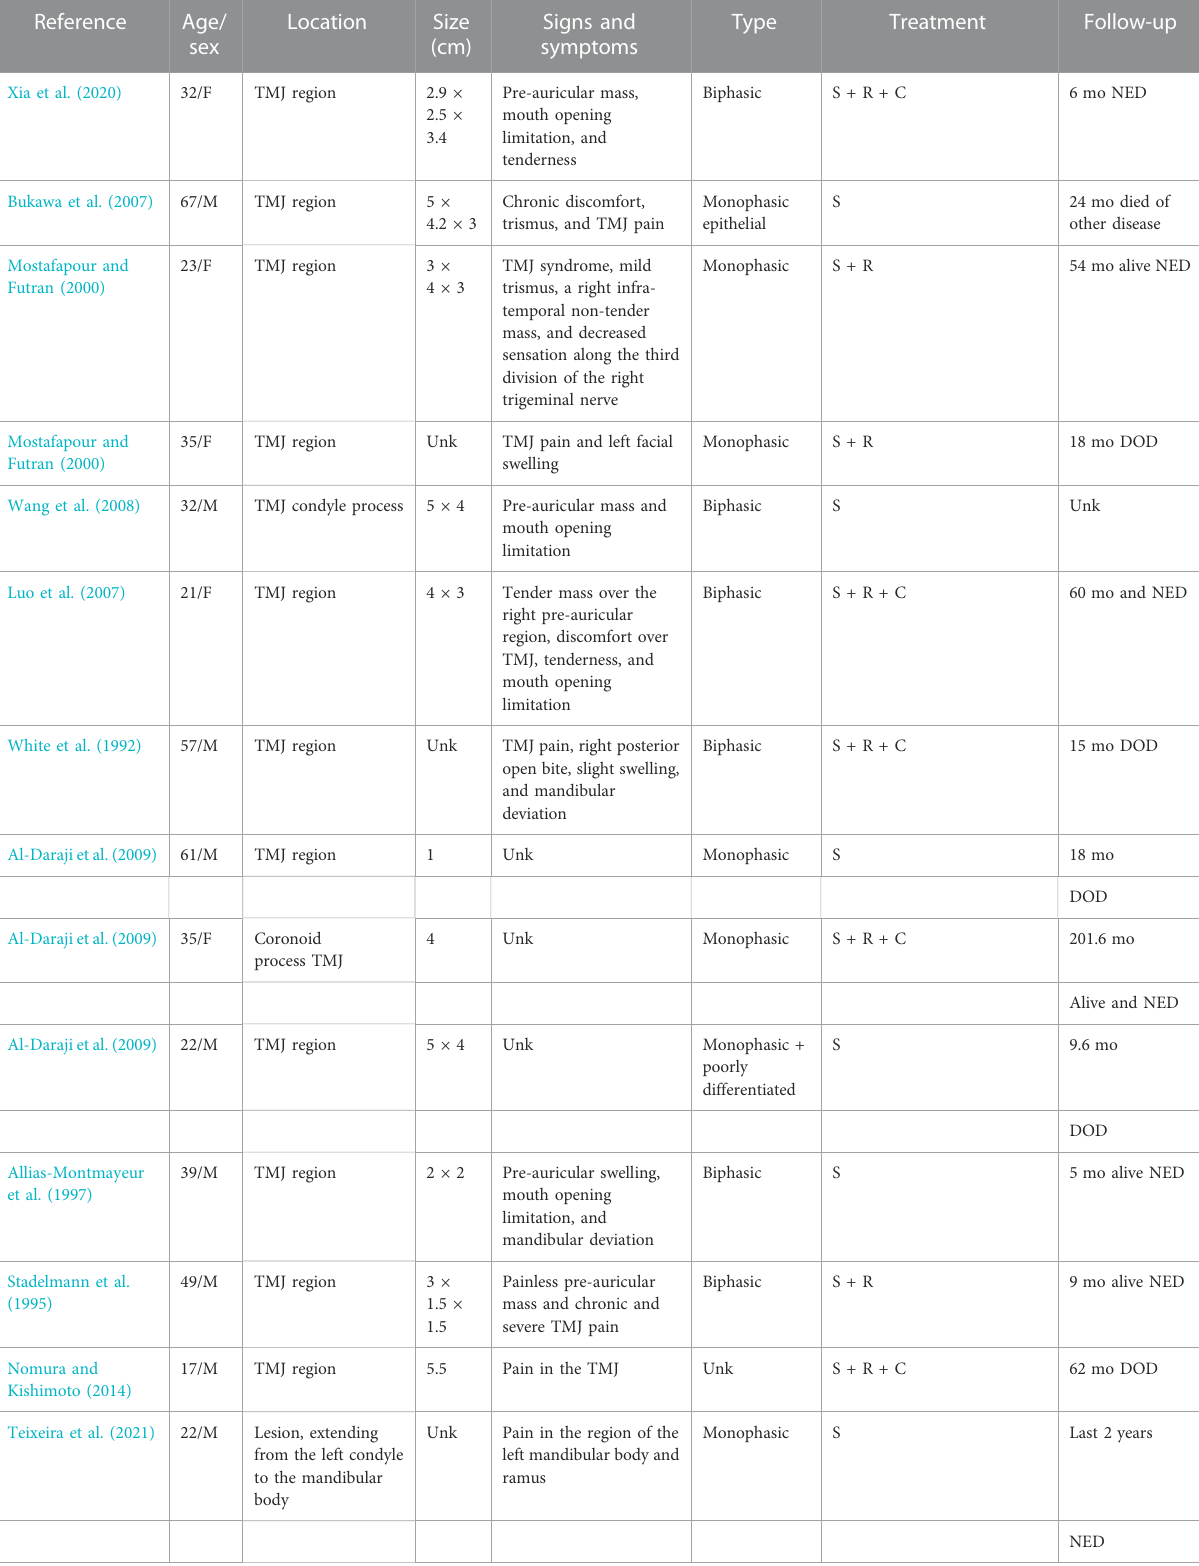
TABLE 2 Reported cases of the oral cavity (TMJ, jaw, and